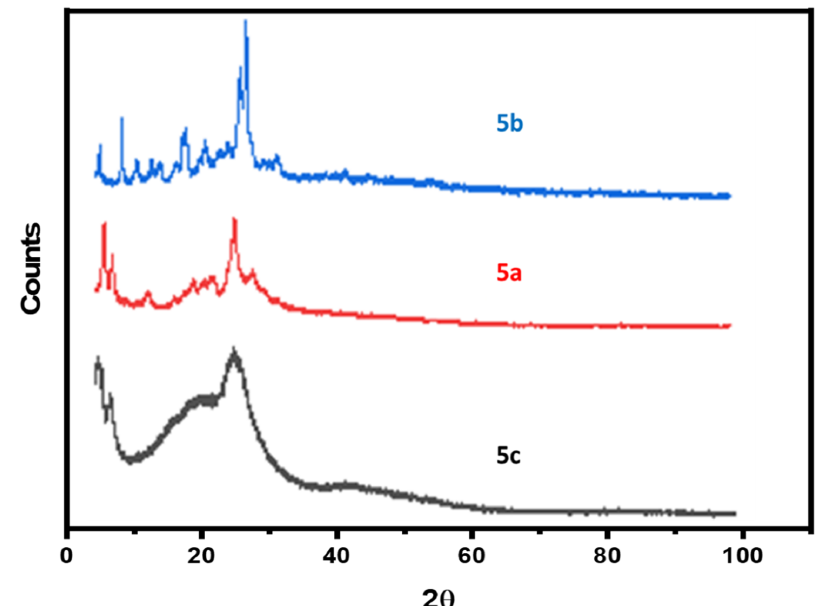
Figure 3. XRD spectrum of samples (5a-c).